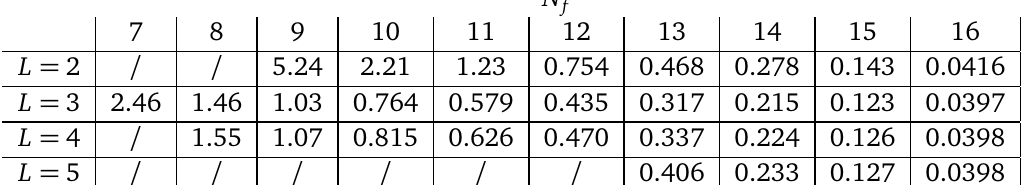
Table 3: Values of the critical coupling α ∗ obeying β ( α ∗ ) = 0 in the scheme of [ 50 ] for different loop order L and number of Dirac flavors N theory. The / denotes the absence of a